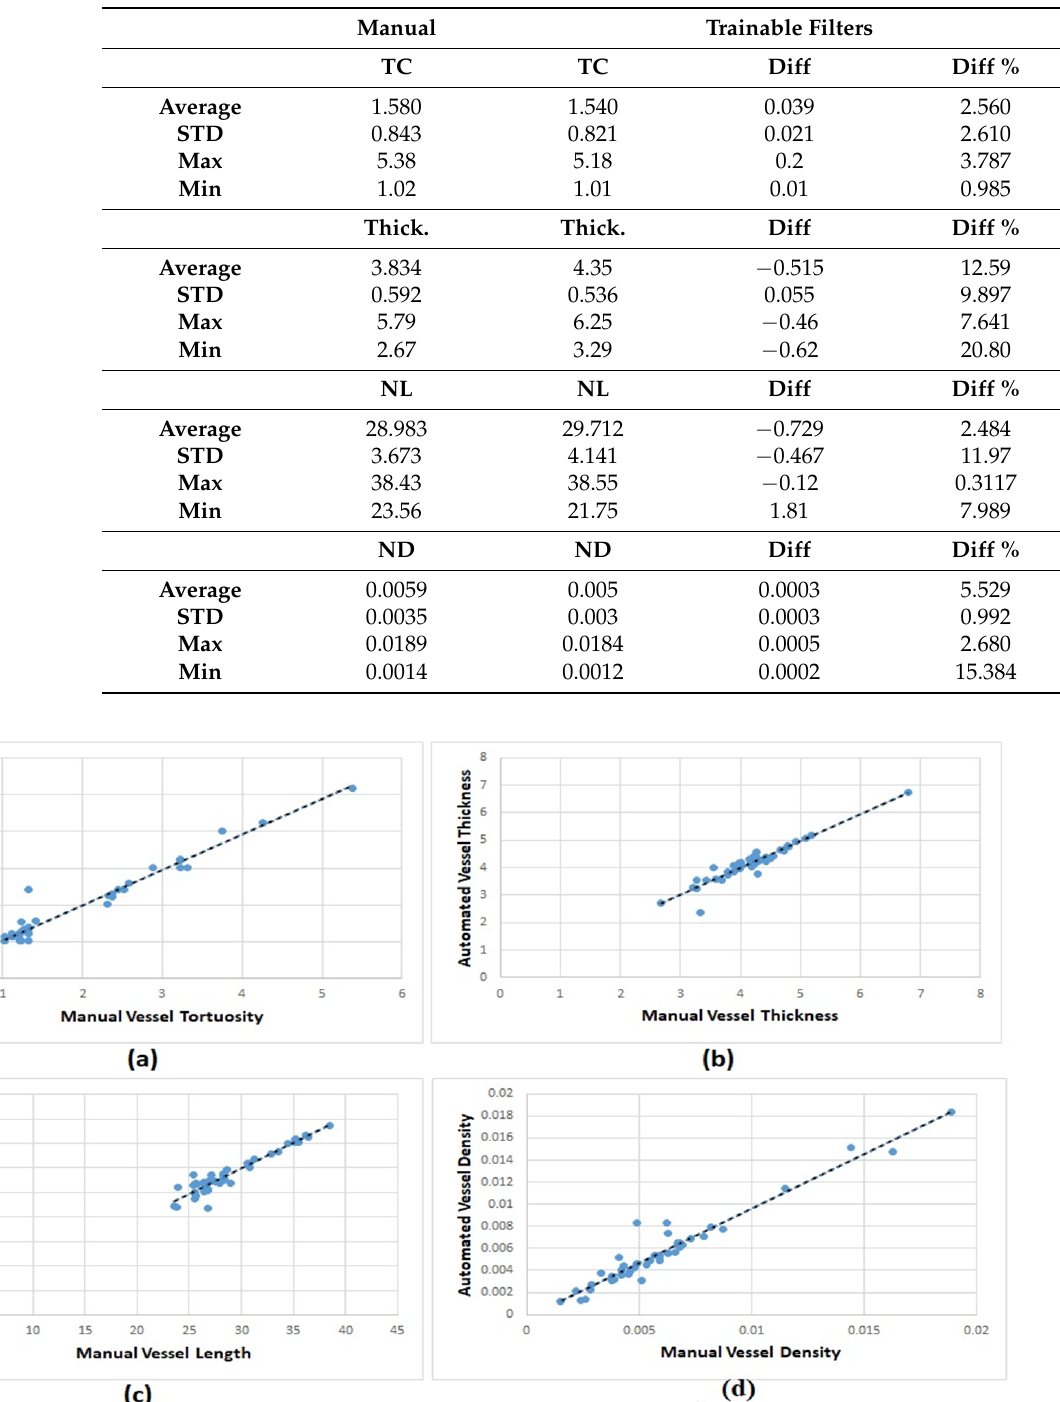
Table 7. Performance comparison conducted between the manual and automated estimations of four clinical features using the HRF dataset.